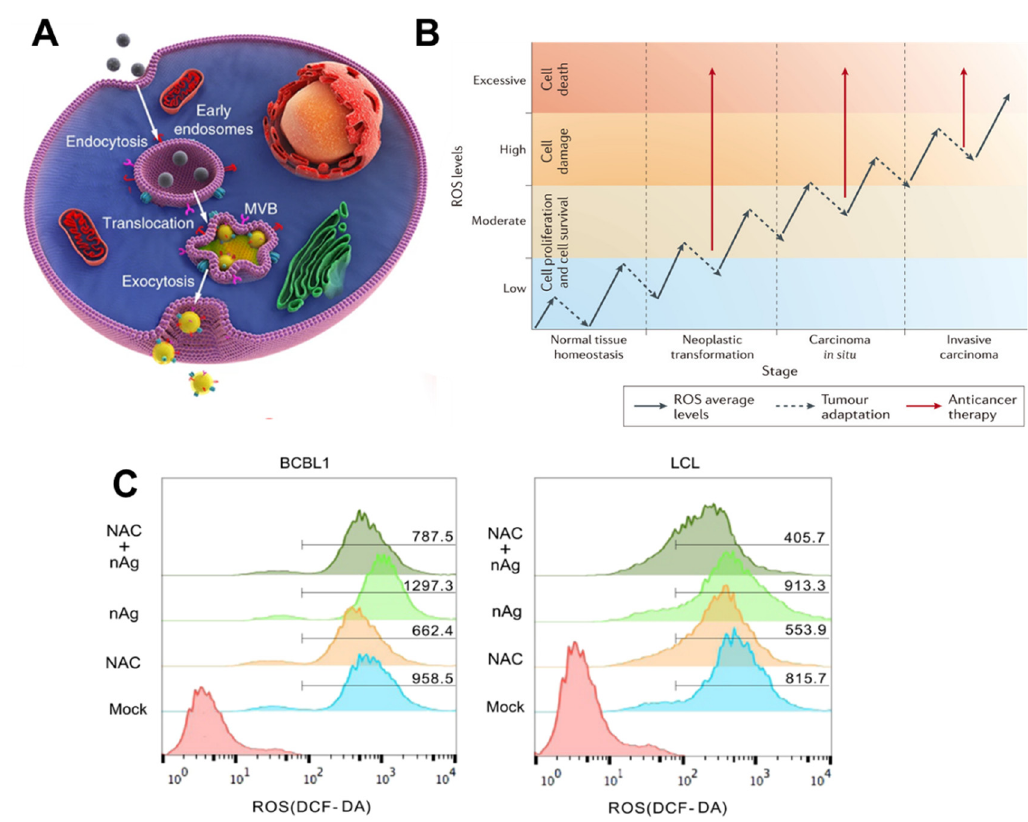
Figure 2. ( A ) Schematic illustration of Doxorubicin (DOX)-coated NPs endocytosed into tumor